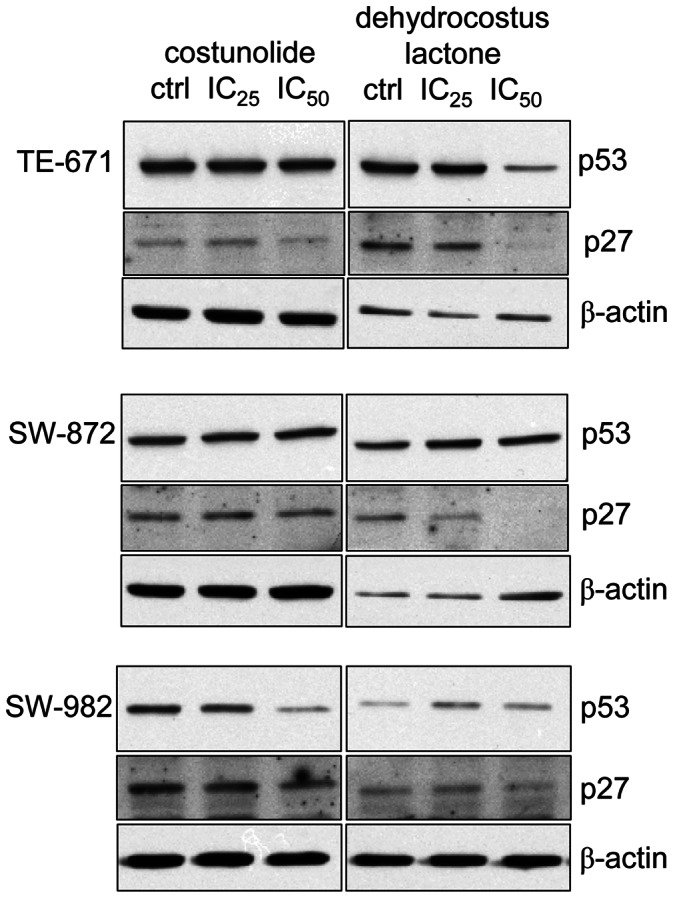
Western blot analysis of p53 and the CDK inhibitor p27Kip1 proteins.Total protein analysis confirmed no significant changes in the p53 expression after costunolide or dehydrocostus lactone treatment. In dehydrocostus lactone treated TE-671 and SW-872 cells, the expression of the CDK inhibitor p27Kip1 was reduced. β-actin was used as loading control. Data shown are representative from at least three independent experiments.